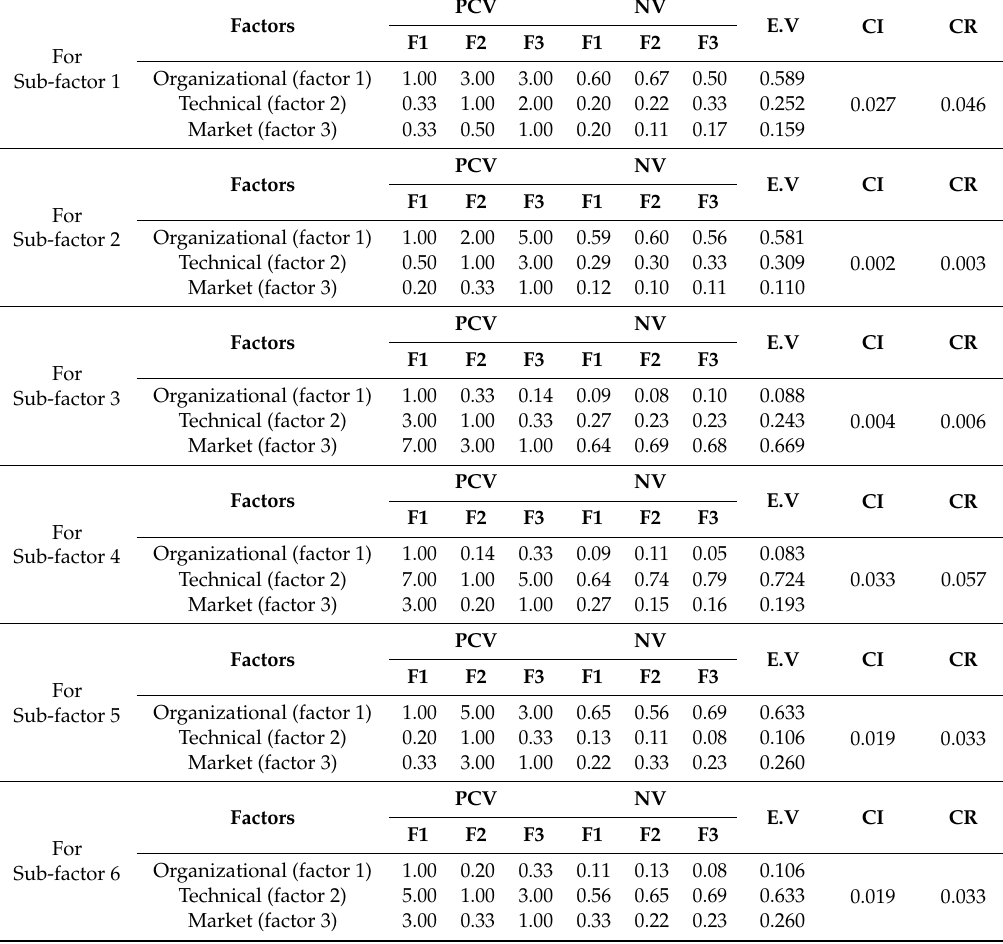
Table 2. The results for the pair-wise comparison of factors with respect to sub-factors.